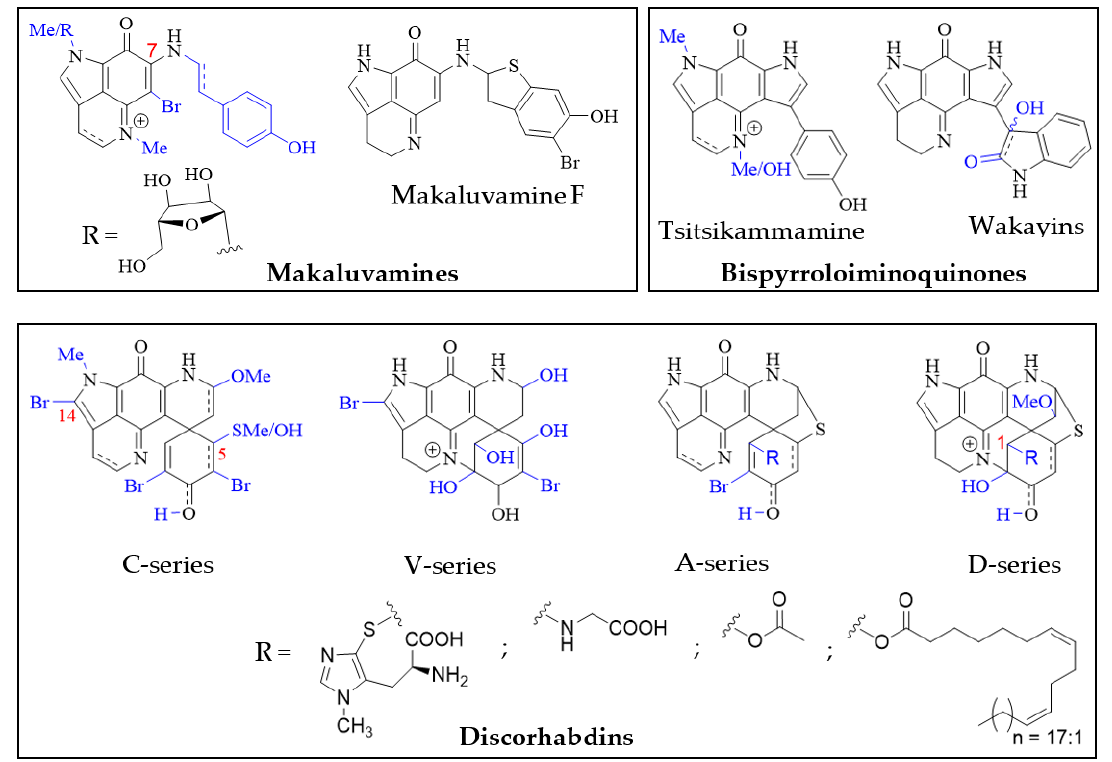
Figure 2. Main pyrroloiminoquinone classes. Variable substituents encompassing all known com- pound class members are shown in blue.